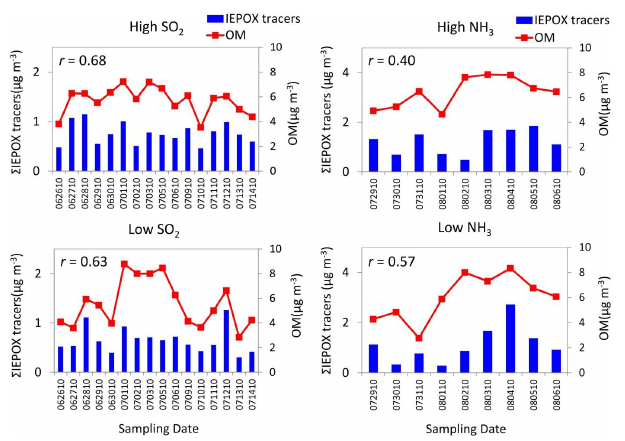
Fig. 4. Temporal variations of low-NO x SOA tracers and OM. Figure 4. Temporal variations of low-NO x SOA tracers and OM. 682